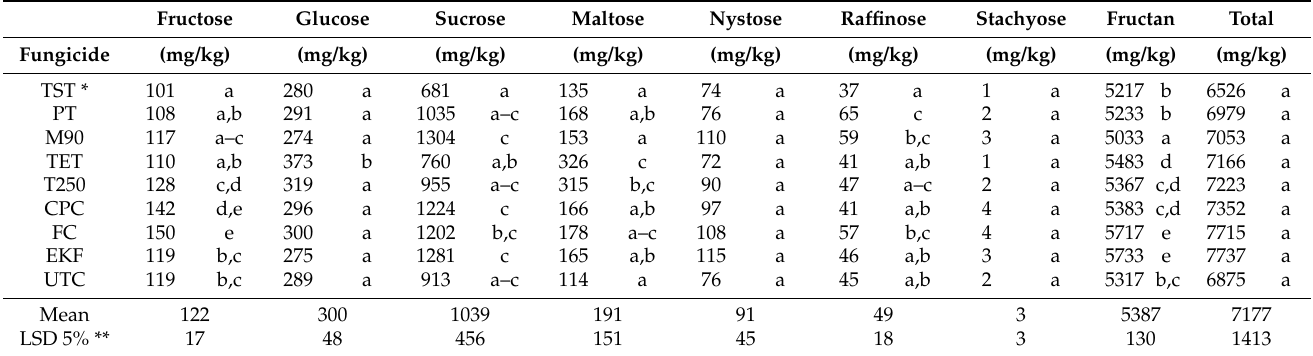
Table 3. Simple carbohydrate content in wheat flour samples treated with various fungicides in a non-epidemic year (2011); results are the average of three wheat